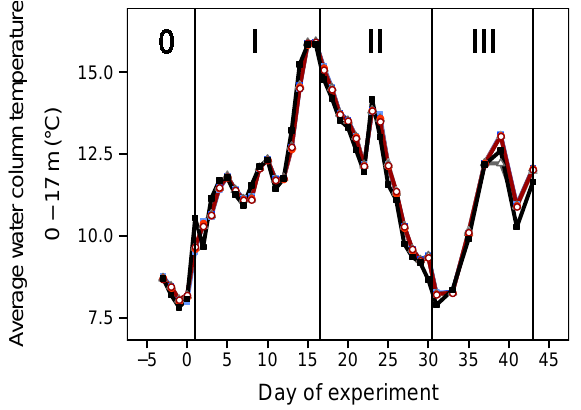
Figure 4. Variation in average water column temperature for all mesocosms and surrounding water during the study period. CO 2 en- richment (after t 0) and temperature variations defined experimental phases. Phase 0: no CO 2 treatments; Phase I: warming; Phase II: cooling; Phase III: second warming phase until end of the experi- ment at t 43. Colours and symbols are described in Table